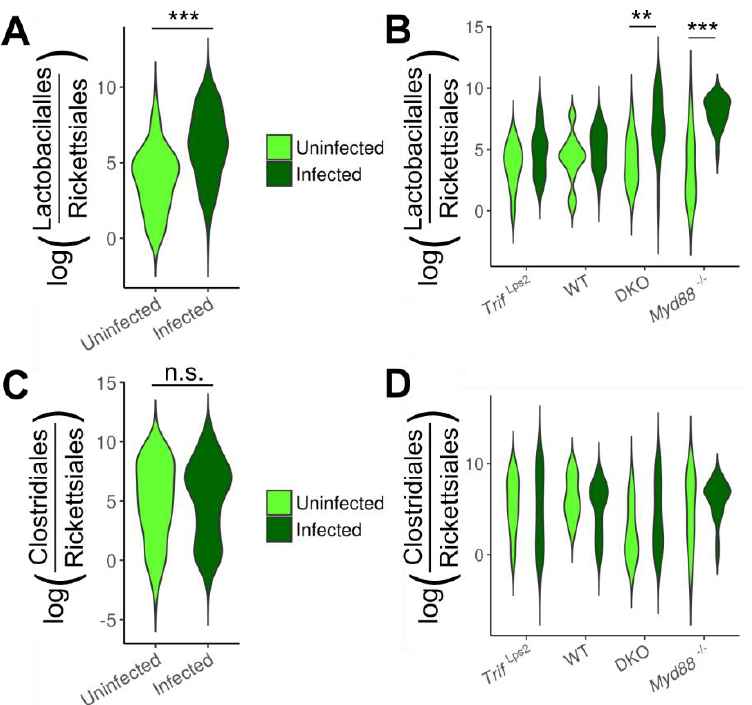
Figure 4. Log ratios between relevant orders across four genotypes. Log ratios of the Lactobacil- lales/Rickettsiales ( A , B ) and Clostridiales/Rickettsiales ( C , D ) relative abundance ratios between samples, months 1–6 combined. ( A , C ) show ratios by infection status, all genotypes combined. ( B , D ) show ratios by genotype and infection status. Log ratios were calculated and processed using Songbird and Qurro. Statistical significance was determined by analysis of variance (ANOVA) ** p < 0.01, *** p < 0.005).